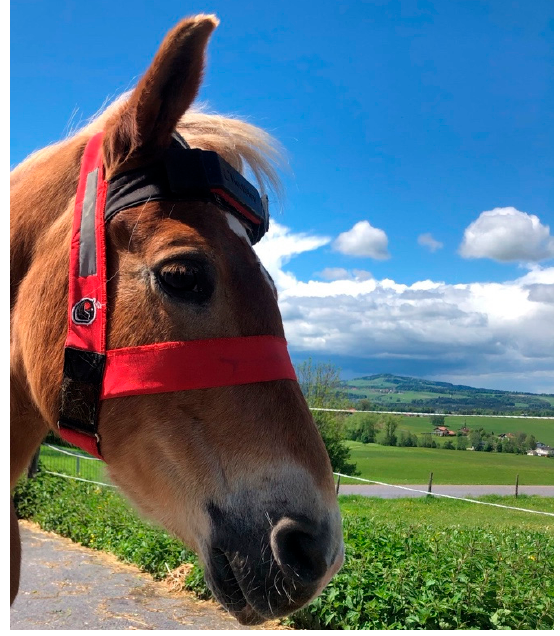
Figure 1. The wearable horse unit of the automated equine monitoring system (Hoofstep ® ) is attached to the horses’ forehead using a special flexible softshell head collar.